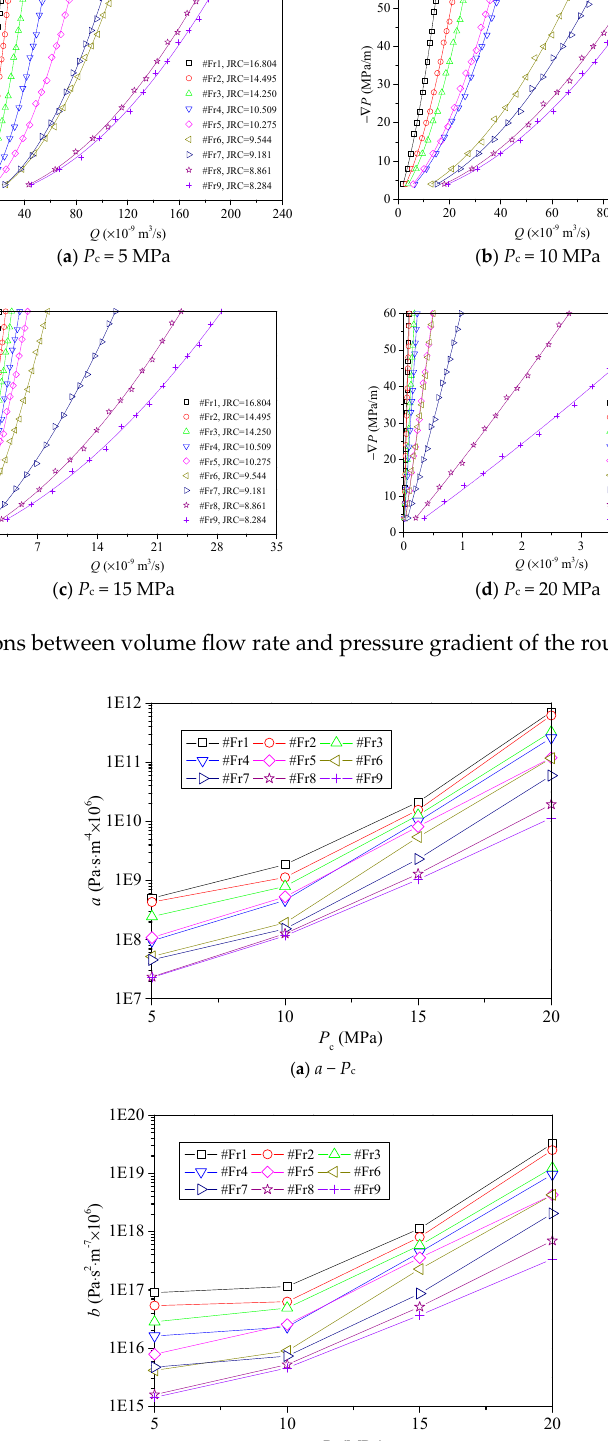
Figure 5. Relations between volume flow rate and pressure gradient of the rough-walled fractures.